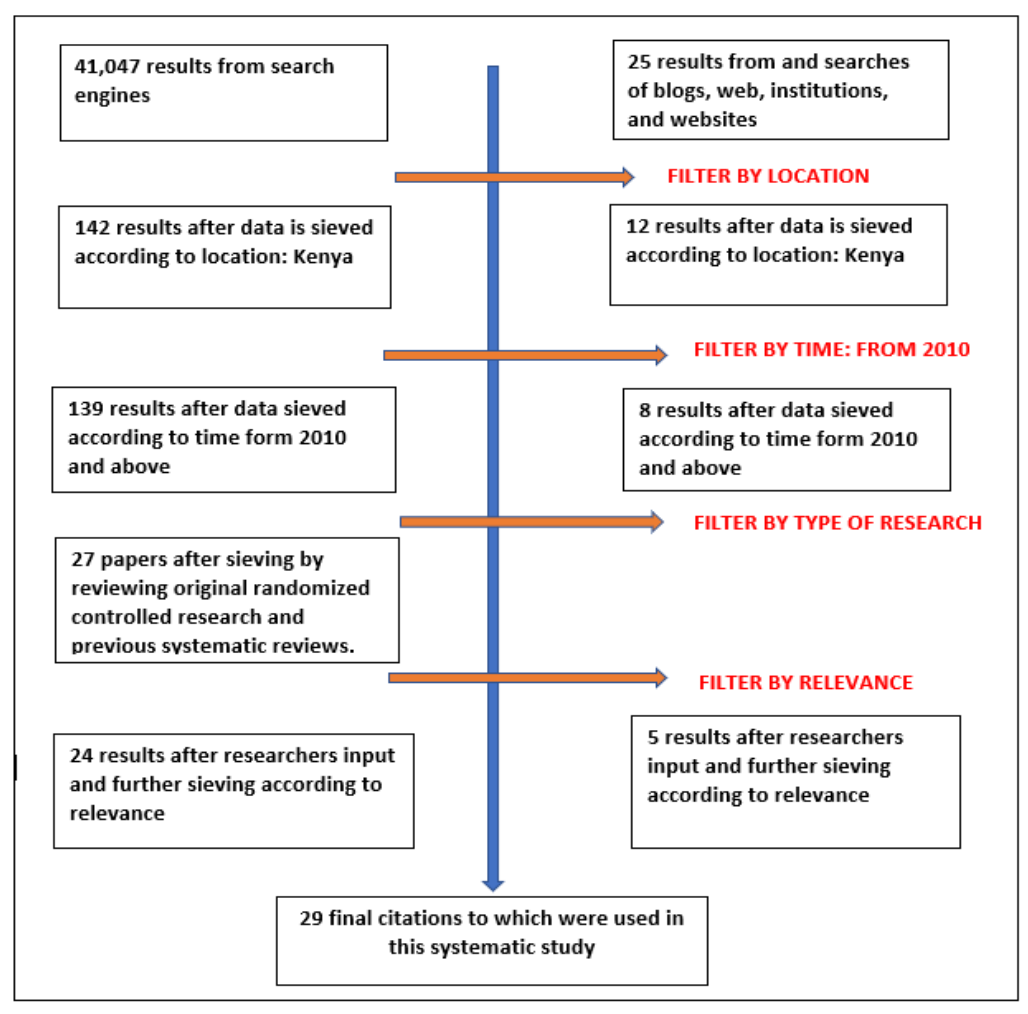
Figure 1: Review Strategy, authors